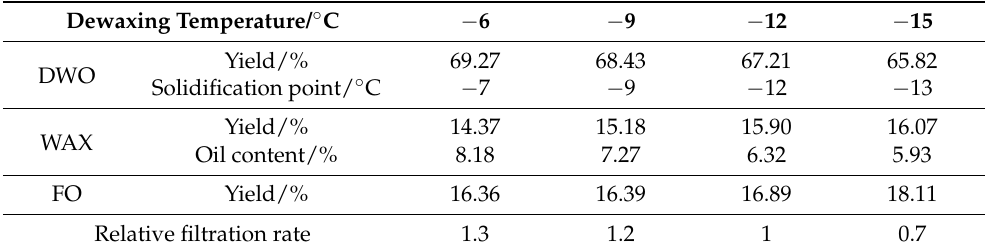
Table 4. Effect of the dewaxing temperature on the MEK–toluene dewaxing of VGO4.